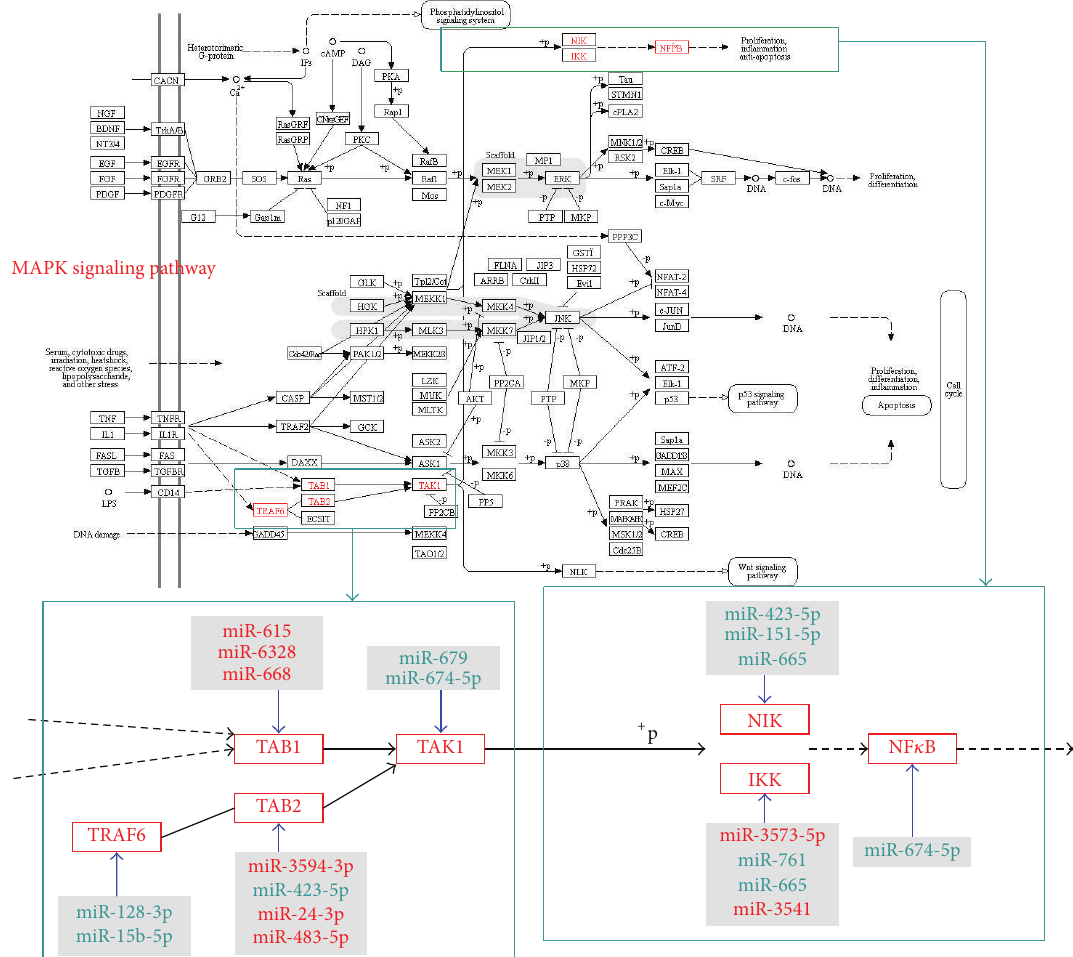
Figure 5: Thumbnail image of MAPK signalling pathway. The genes labelled red were genes that were regulated by differentially expressed miRNA. The miRNAs labelled red were the upregulated miRNAs, and the miRNAs labelled green were the downregulated